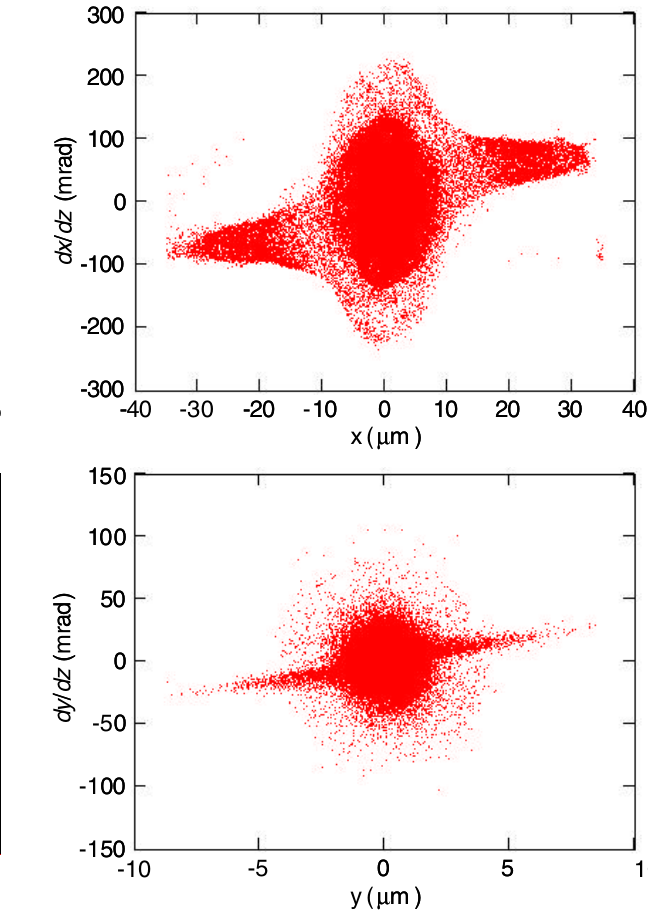
FIG. 2. (Color) LWFA phase space, as simulated by 3D PIC code. Top: electron beam energy spectrum. Bottom: temporal electron pulse profile.